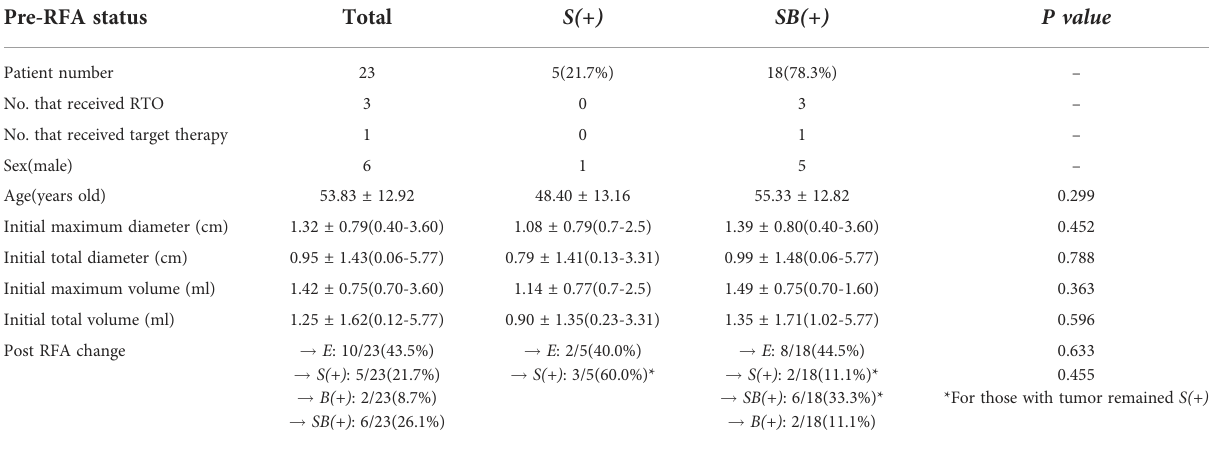
TABLE 1 Basic characteristics of all patients